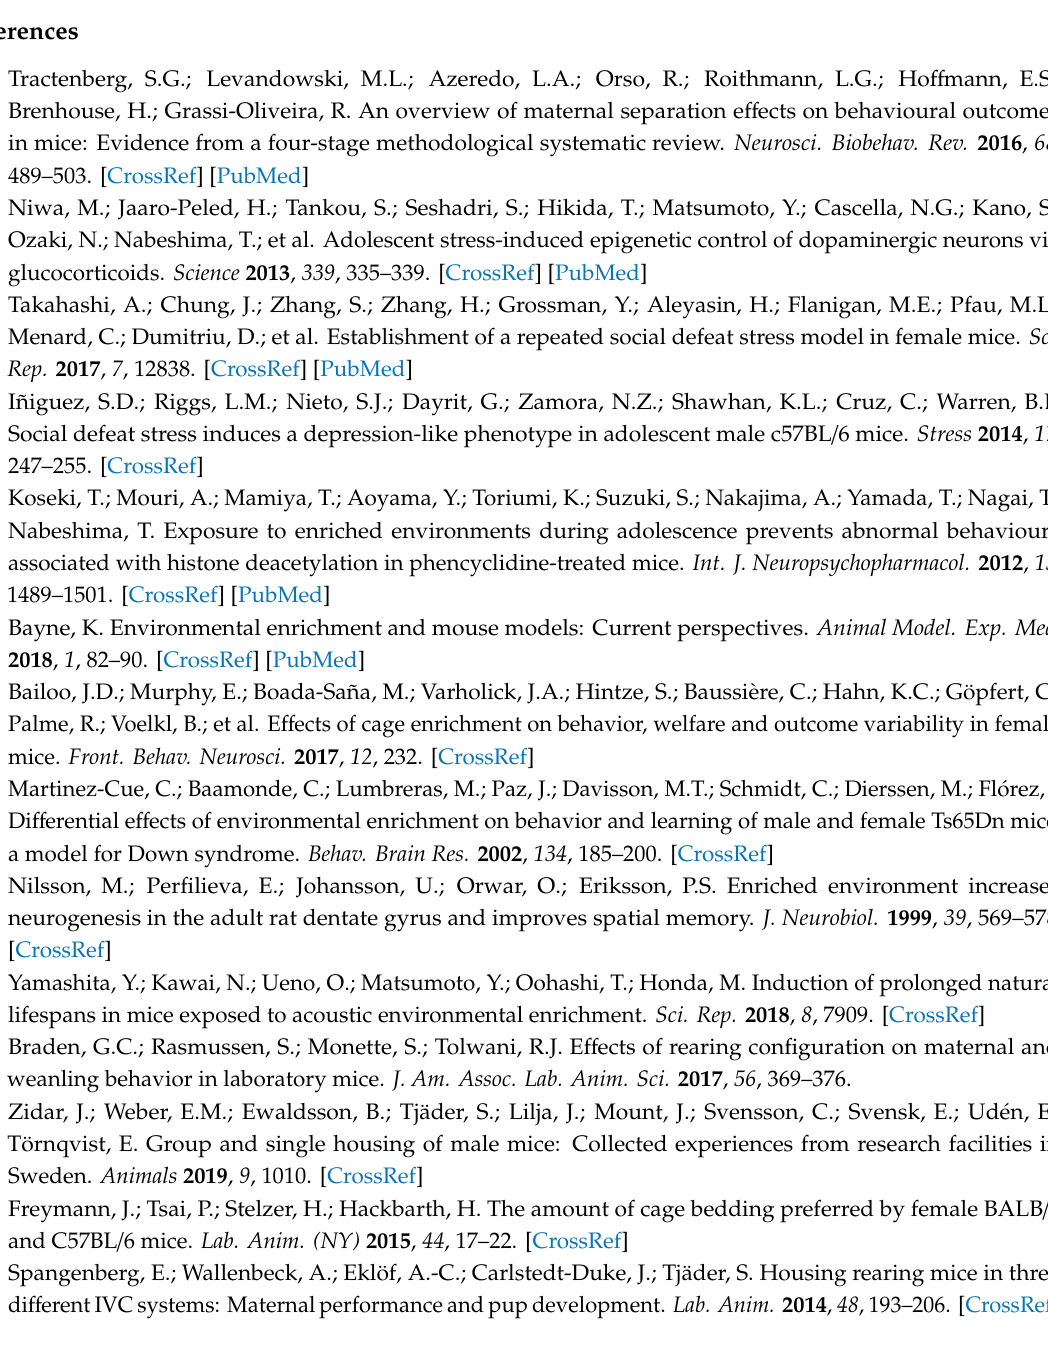
Figure S2: Changes in the bulge of the rump in the chamber and IVC groups at 94 weeks of age (https: // doi.org / 10.5281 /